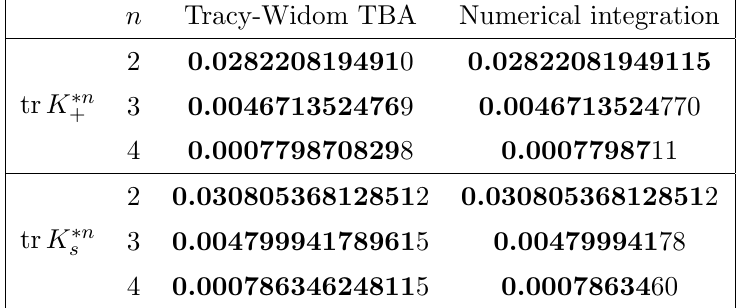
Table 1 . We have computed the (cid:12)rst few powers of the two kernels using both the Tracy-Widom TBA and the direct numerical integration of the expansion (3.1). We show here the agreement between both approaches to some precision for the choice mL = 1. The digits in bold are signi(cid:12)cant (on the TBA side one can easily increase the